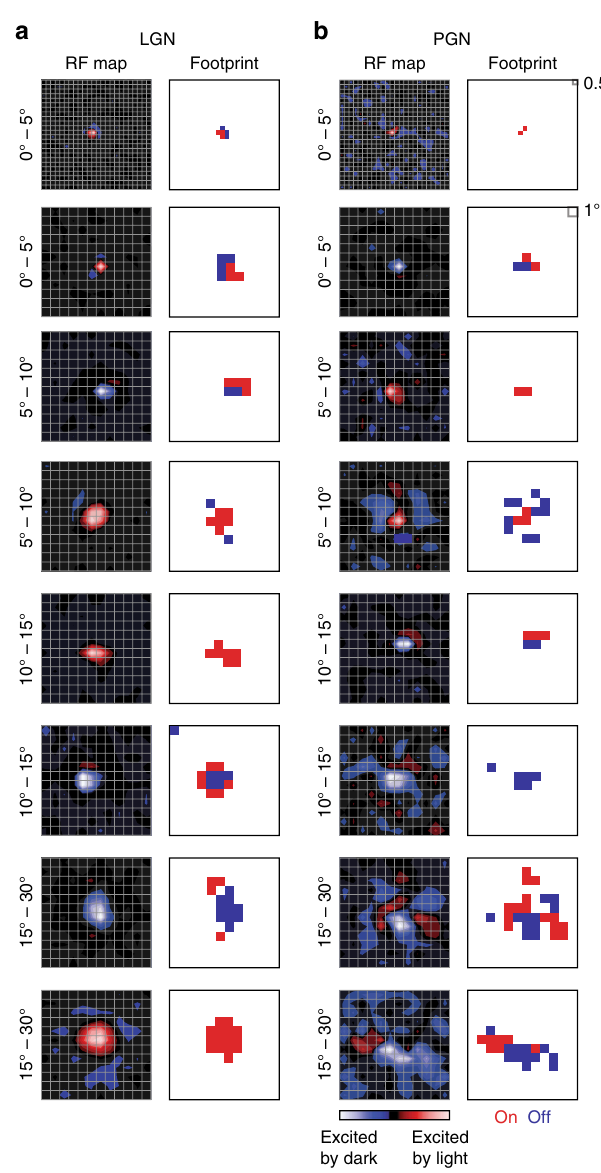
Fig. 3 Spatial scales of receptive fi elds in the LGN and PGN are comparable. a Spatial receptive fi elds ( left column ) and footprints ( right column ) of eight example LGN relay cells ranked by their eccentricities (as